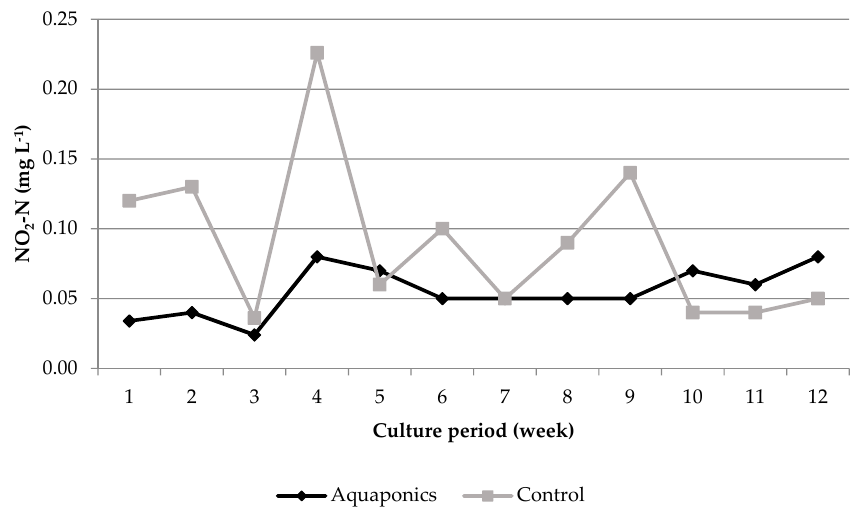
Figure 6. Temporal changes of nitrite (NO 2 -N) over the experimental period of 12 weeks.